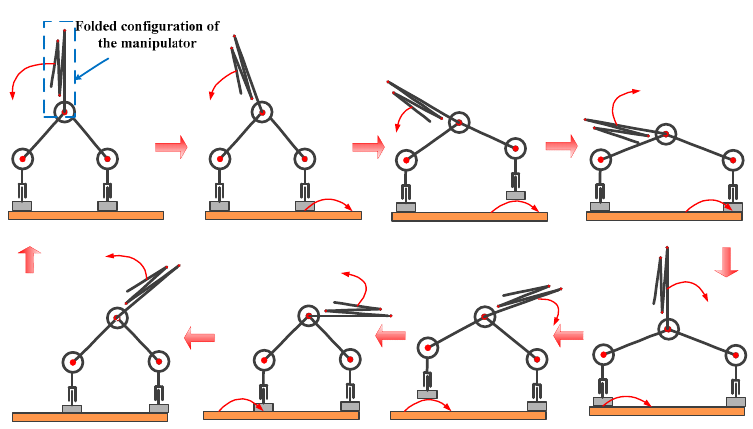
Figure 9. Schematic diagram of the motion of the climbing mechanism.